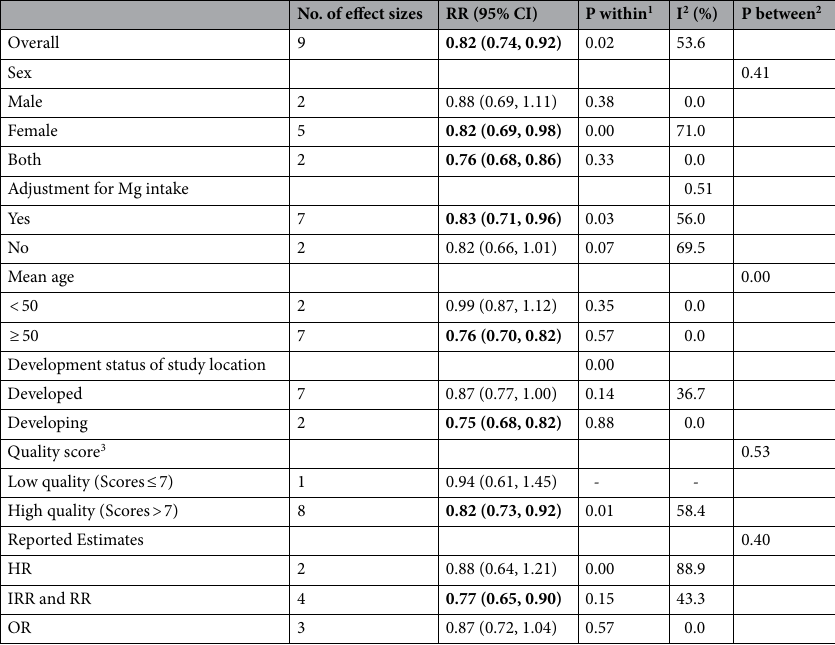
Table 3. Results of subgroup-analyses of dietary Ca intake in relation to T2DM in prospective cohort studies. 1 P for heterogeneity, within subgroup. 2 P for heterogeneity, between subgroups. 3 Quality Scores were according to Newcastle–Ottawa